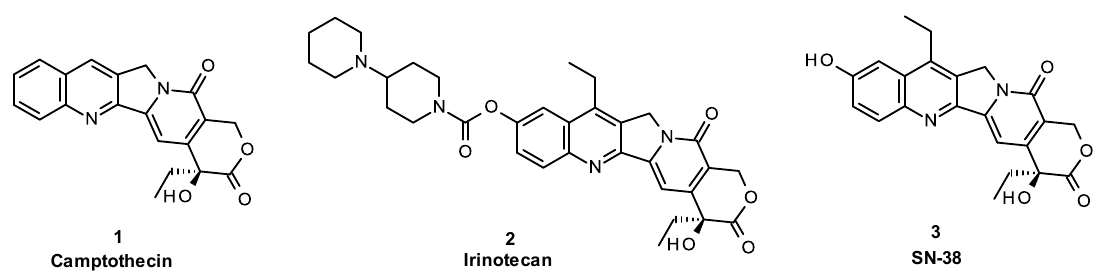
Figure 1. Structure of camptothecin and its